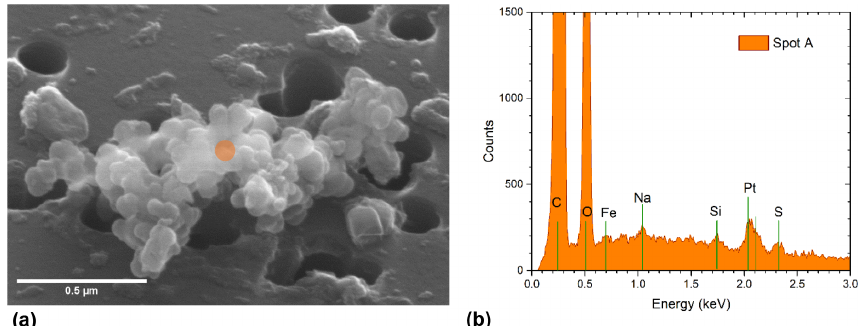
Figure 12. Same as Fig. 4 but for a soot (BC) particle. The EDX spectrum of the particle reveals trace elements of Fe, Na, Si, and S in addition to the dominating C, O pattern that is characteristic for carbonaceous